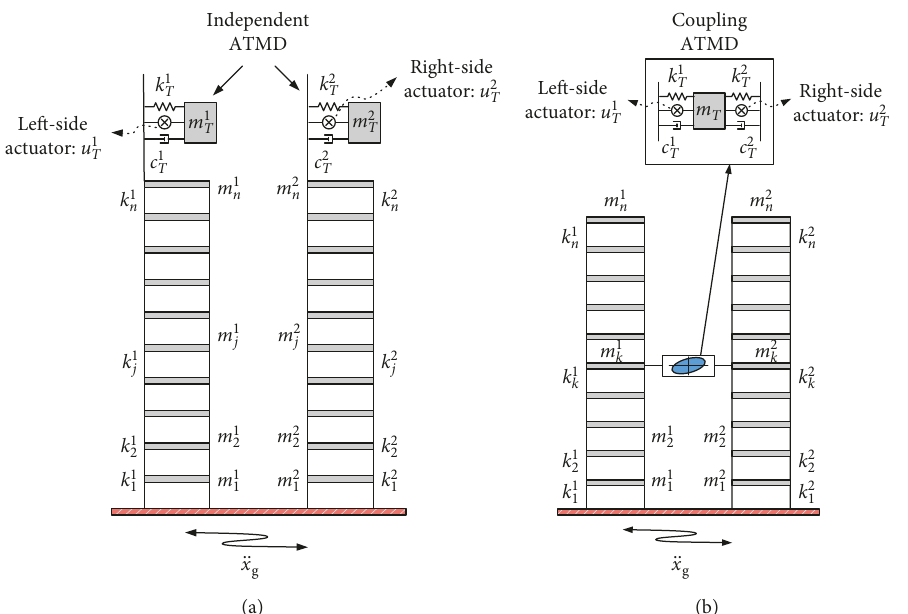
Figure 1: Configurations of independent ATMD and coupling ATMD systems for seismic reinforcement of adjacent buildings. (a) Independent ATMD system. (b) Coupling ATMD